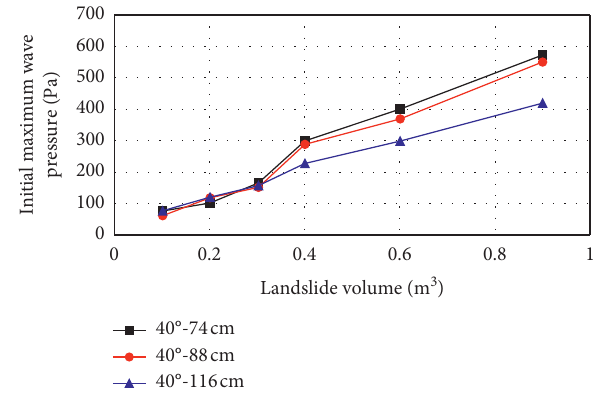
Figure 12: Variation of initial maximum wave pressure with landslide volume at three water depths (at 40 ° ).